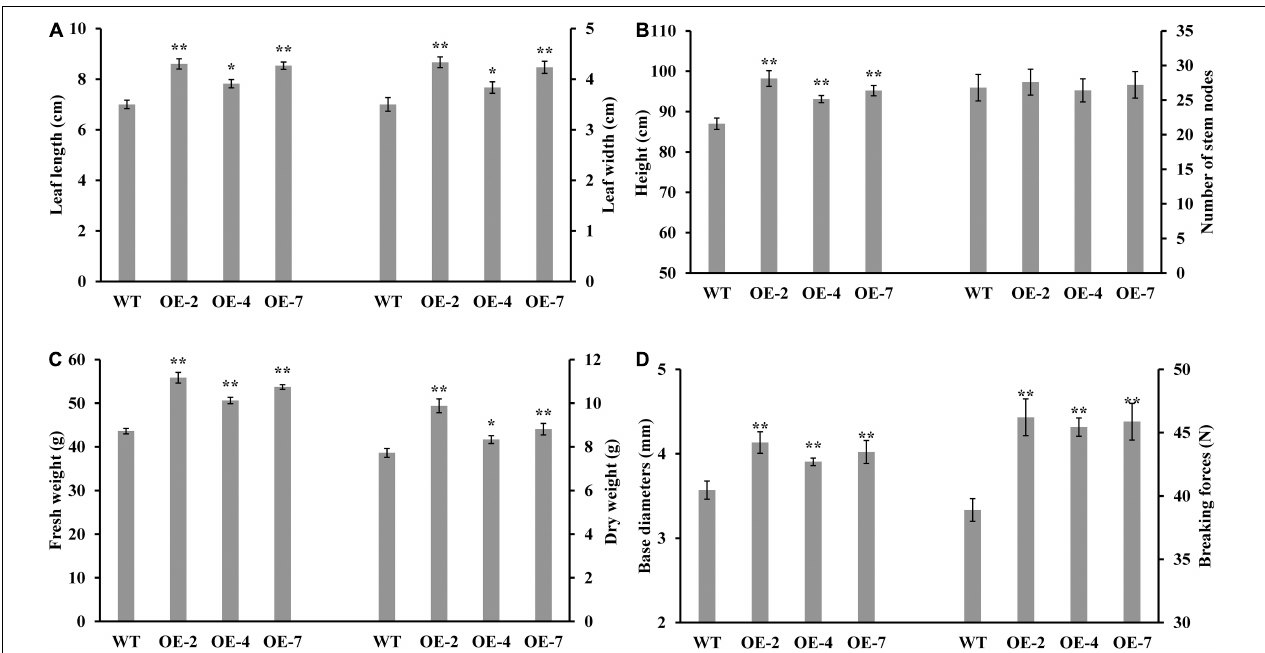
FIGURE 2 | Effect of PtrWOX13A overexpression on growth-related traits in Populus trichocarpa transgenic lines. (A) Average leaf length and leaf width; (B) Average height and number of stem nodes and standard error of each transgenic line; (C) Average fresh weight and dry weight; (D) Average base diameters and breaking forces. All the data were measured on the 90-day-old wild type (WT) and PtrWOX13A transgenic lines (OE-2, OE-4, and OE-7). Each error bar represents the standard deviation of three biological replicates. Asterisks denote levels of significance (Dunnett’s test; * p < 0.05 significant, and ** p < 0.01, highly